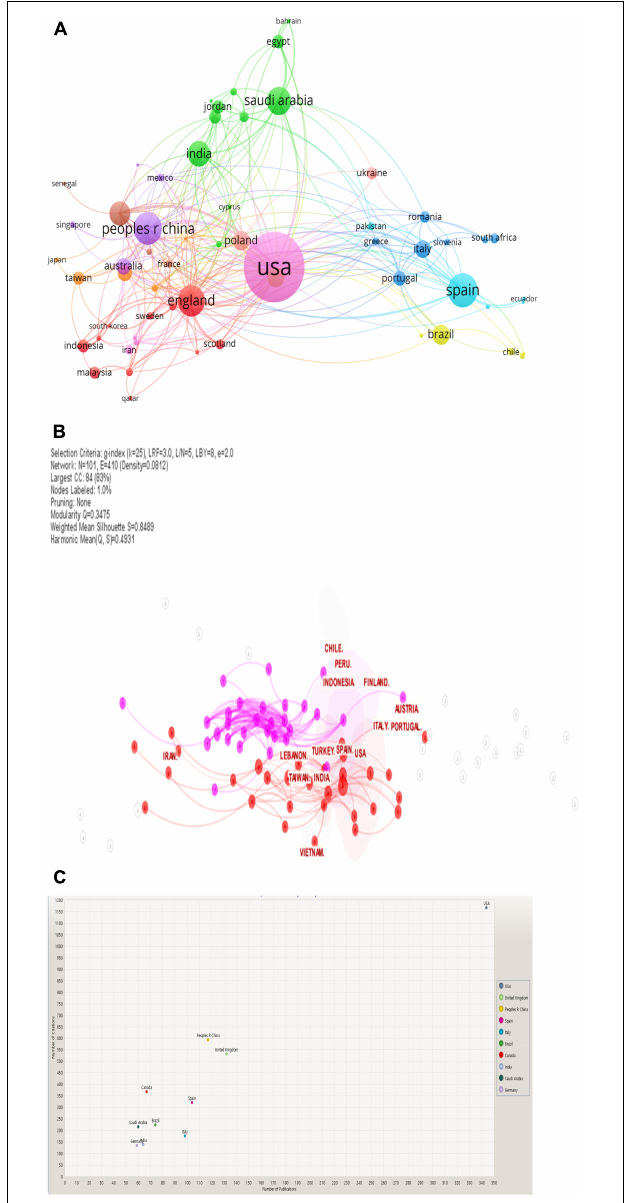
FIGURE 5 | (A) Network of countries (VOSviewer outputs). (B) Network of countries (CiteSpace outputs). (C) Citations per publications by country (KnowledgeMatrix Plus